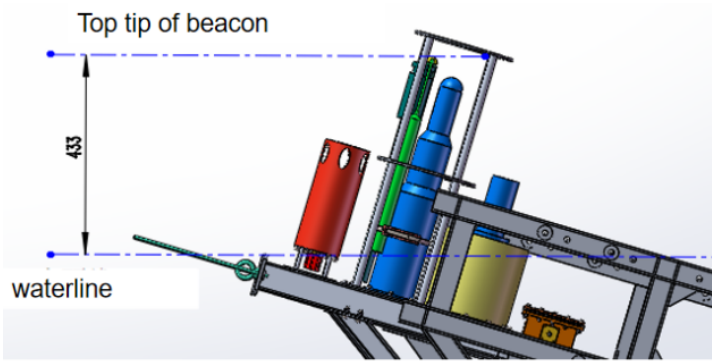
Figure 5. Freeboard of the top tip of the beacon. The subsystems of the ARV are designed as